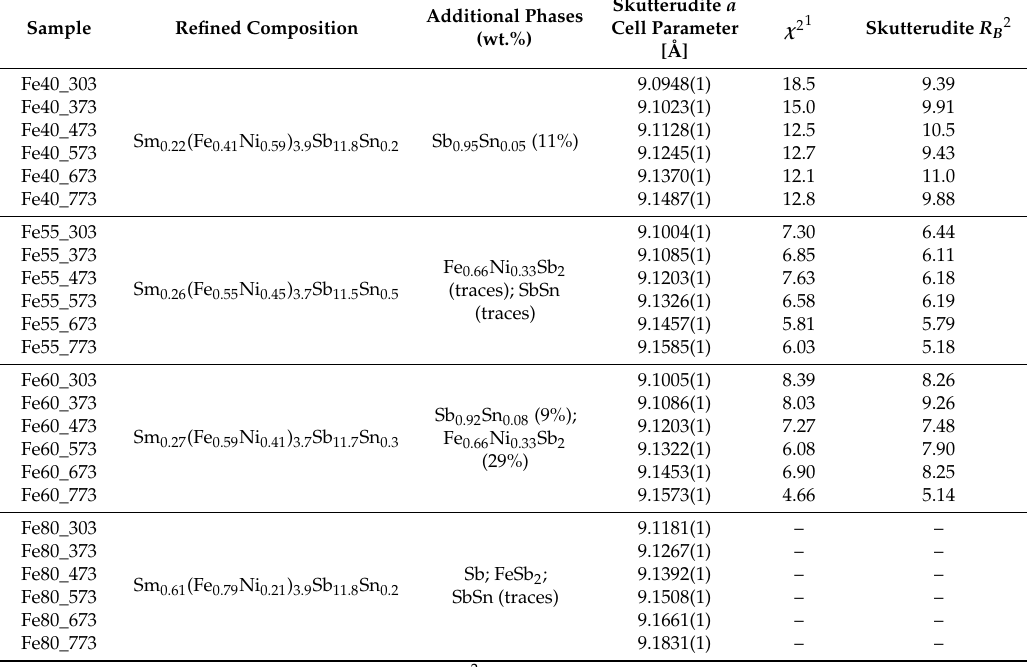
Figure 2. SEM microphotographs taken by secondary electrons on the polished surface of the samples ( a ) Fe40, ( b ) Fe55, ( c ) Fe60, and ( d ) Fe80. Table 1. Refined composition, amount of additional phases as revealed by EDS and X-ray di ff raction, skutterudite cell parameter, and Rietveld agreement factors for each sample. Sample Fe80 is mainly composed of the extra phases Sb and FeSb 2